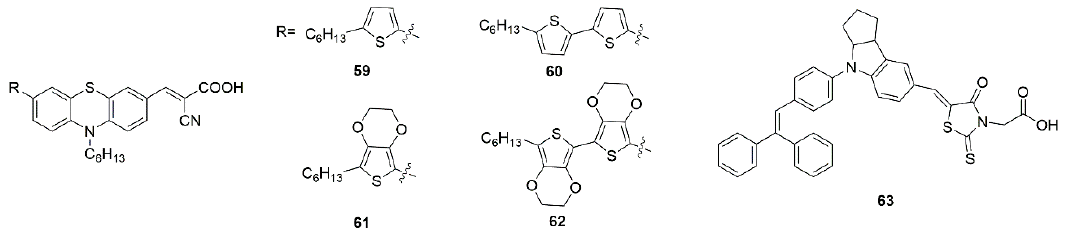
Figure 15. Chemical structures of dyes 59 – 63 .